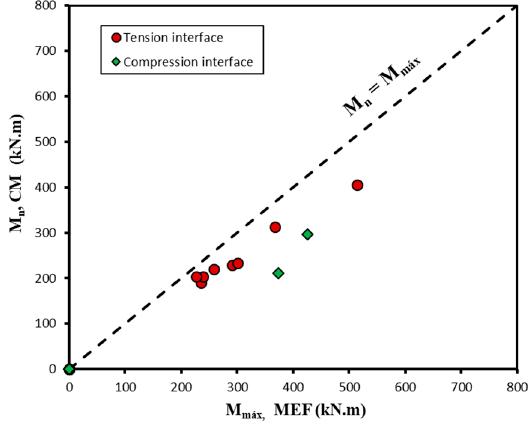
Figure 10. Comparison of FEM results with estimations of the component method (CM).